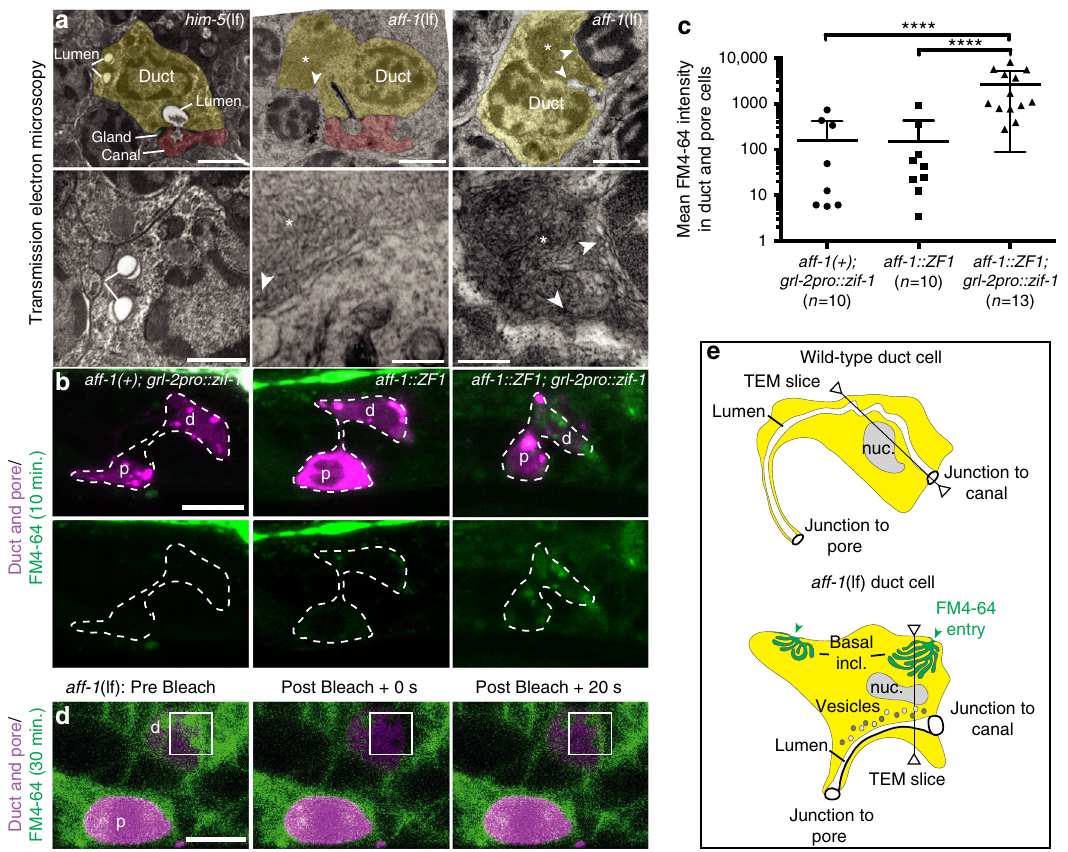
Fig. 5 AFF-1 is required for endocytic scission. a Transmission electron micrographs, showing transversal sections of the excretory duct cell body in L1 larvae. Duct is post-colored in yellow and canal cell is post-colored in red when applicable. Dorsal side up. Lower panels show a higher magni fi cation of upper panels. The control ( him-5 ( e1490 )) duct has a lumen crossing the section three times and a continuous basal membrane. Both aff-1 ( tm2214 ) mutant duct cell bodies have one or no lumen crossings but contain large membrane inclusions (asterisks). White arrowheads indicate regions where the inclusion appears continuous with the basal plasma membrane; these regions are magni fi ed in lower panels. See also Supplementary Fig. 5. b FM4-64 dye fi lling assays in L1 animals. Confocal slices are shown, with duct (d) and pore (p) cells in magenta and FM4-64 in green. Left panels: grl-2pro::zif-1::mCherry control. Middle panels: aff-1::zf1 control, with duct and pore cells marked by grl-2pro::mCherry . Right panels: aff-1::zf1; grl-2pro::zif-1::mCherry for duct/pore- speci fi c degradation of AFF-1. AFF-1-depleted cells show a very strong FM4-64 signal compared to the controls. c Quanti fi cation of dye fl uorescence intensity, plotted on a logarithmic scale. **** = p- value < 0.0001, Mann – Whitney test. Error bars = ± SD. d Fluorescence recovery after photobleaching (FRAP) experiment on aff-1 ( tm2214 ) mutant duct cell at L1 stage. FM4-64-marked inclusions within the bleached region of interest (white square) recovered rapidly. See Supplementary Fig. 6 for further details. e Schematic interpretation. Scale bars = 1 μ m ( a upper panels), 300 nm ( a lower